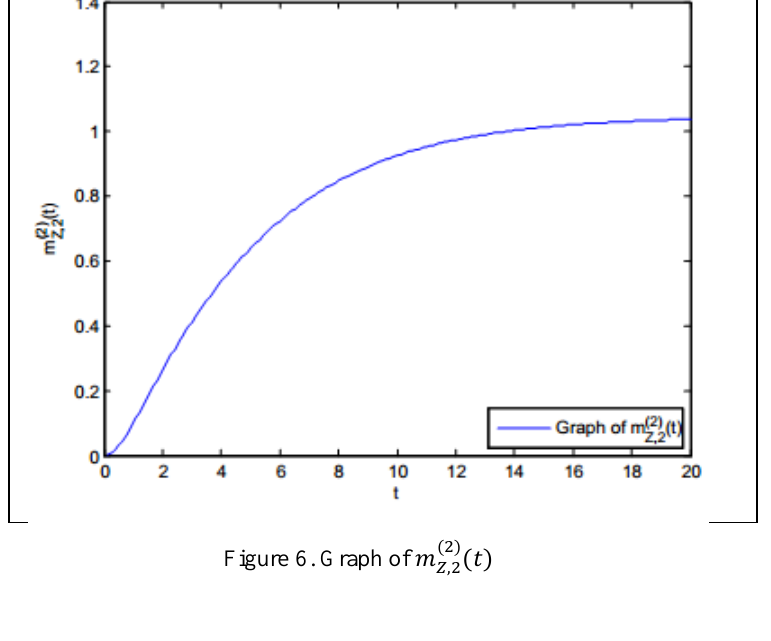
Figure 6. Graph of 𝑚 𝑍,2(2) (𝑡)